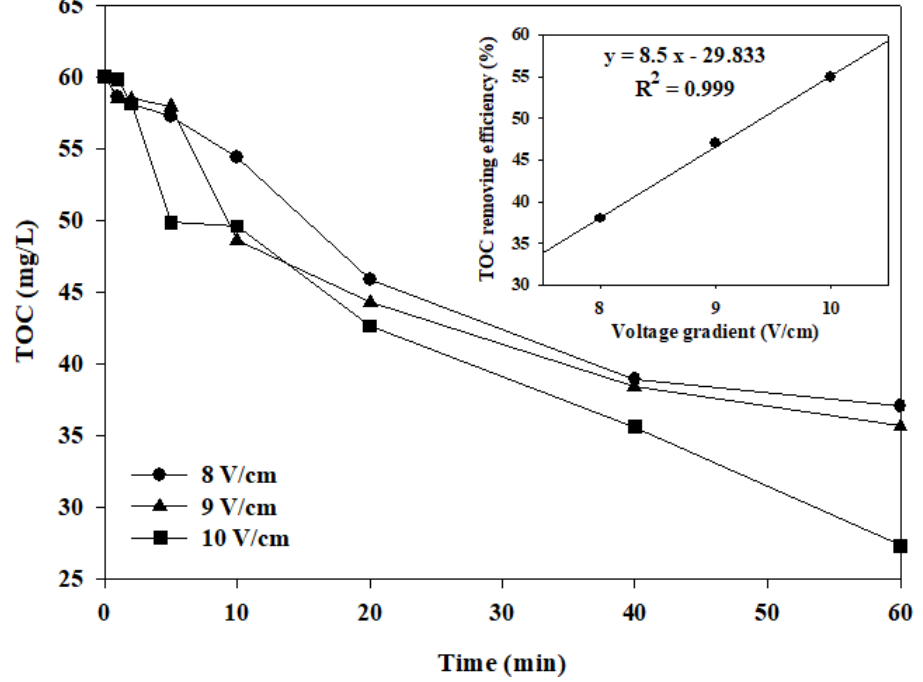
Figure 6. The variation of TOC concentration with different voltage gradients. The mineralization current efficiency (MCE) of the DBP was calculated according to the following equation